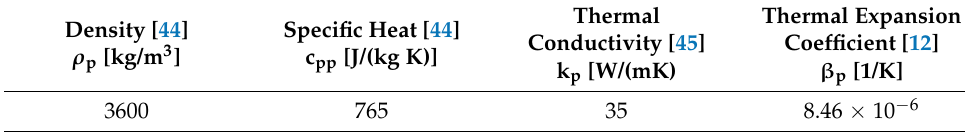
Table 1. Properties of Al 2 O 3